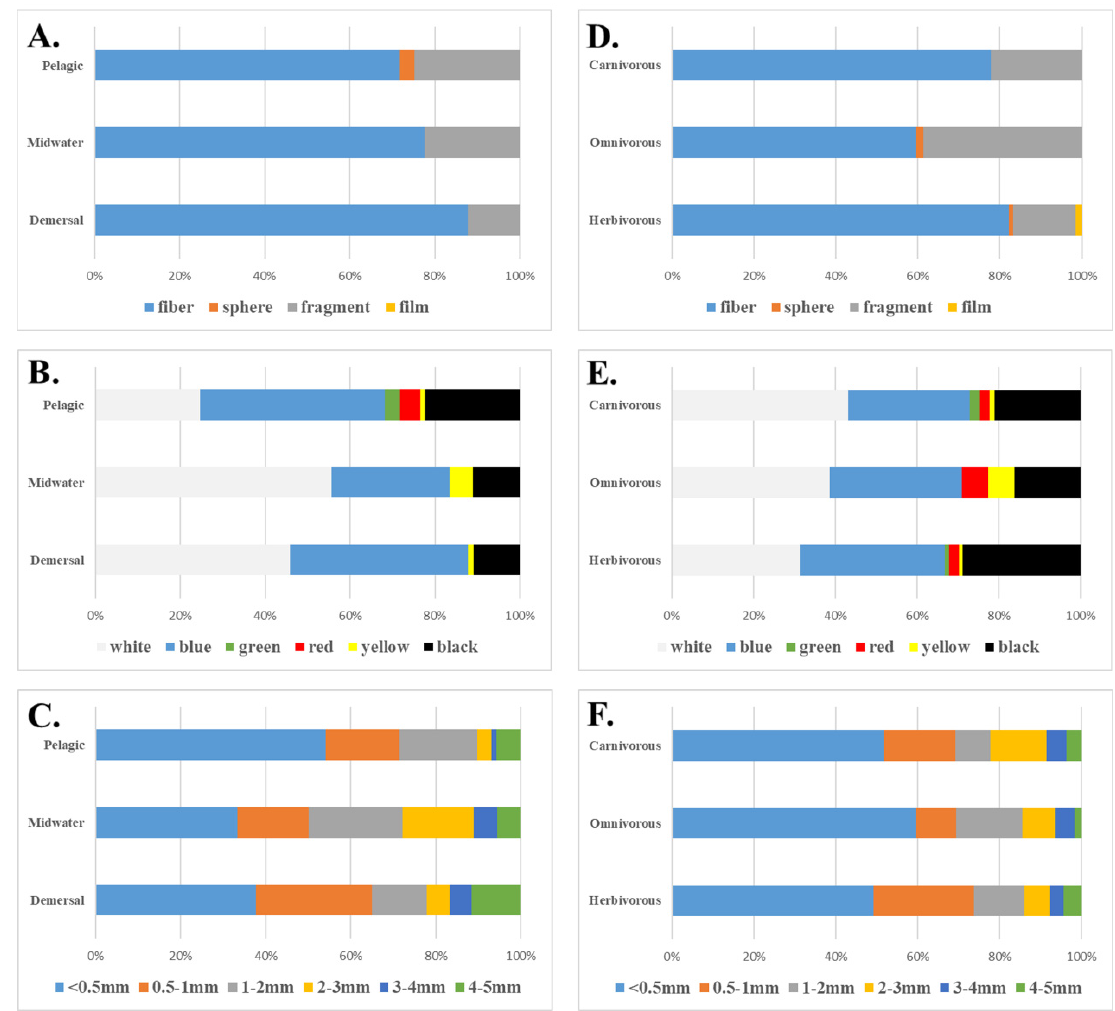
Figure 4. Proportion of microplastic shape ( A / D ), color ( B / E ) and size ( C / F ) in distribution ( A – C ) and feeding distribution ( D – F ) in fish samples from the coastal areas of central and western Guangdong province.